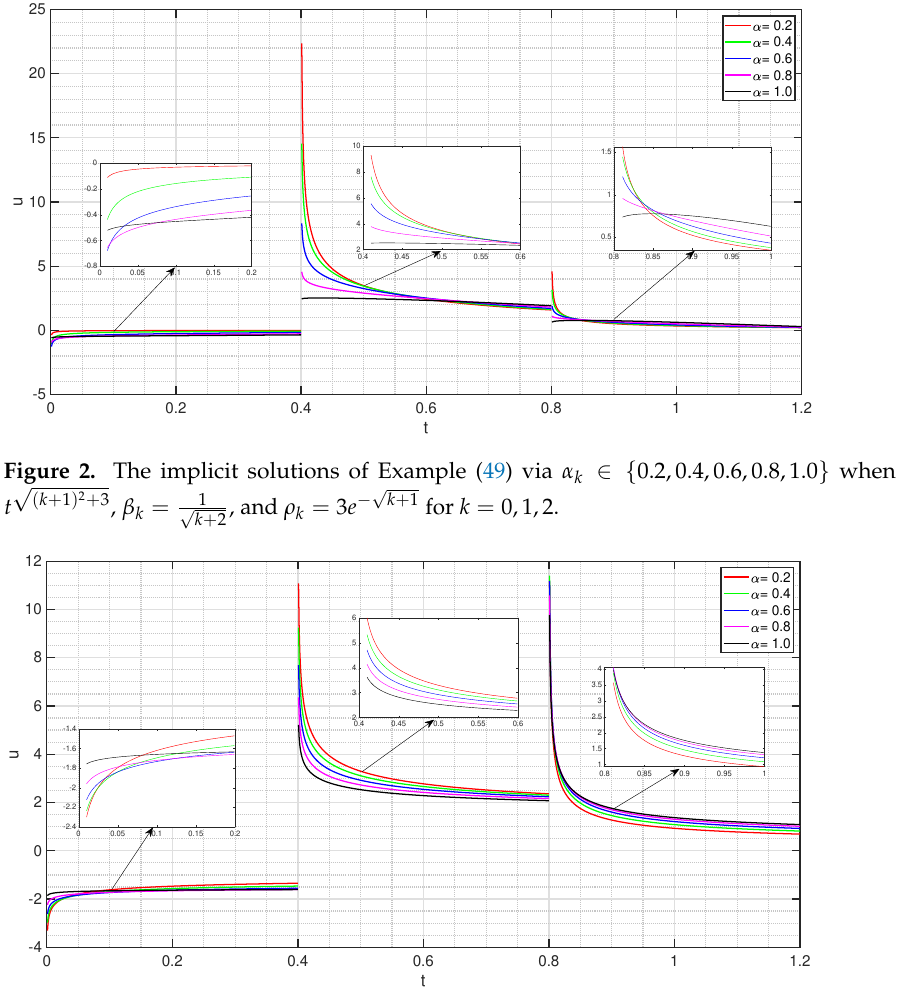
Figure 3. The implicit solutions of Example (49) via α k ∈ { 0.2,0.4,0.6,0.8,1.0 } when φ k ( t ) =